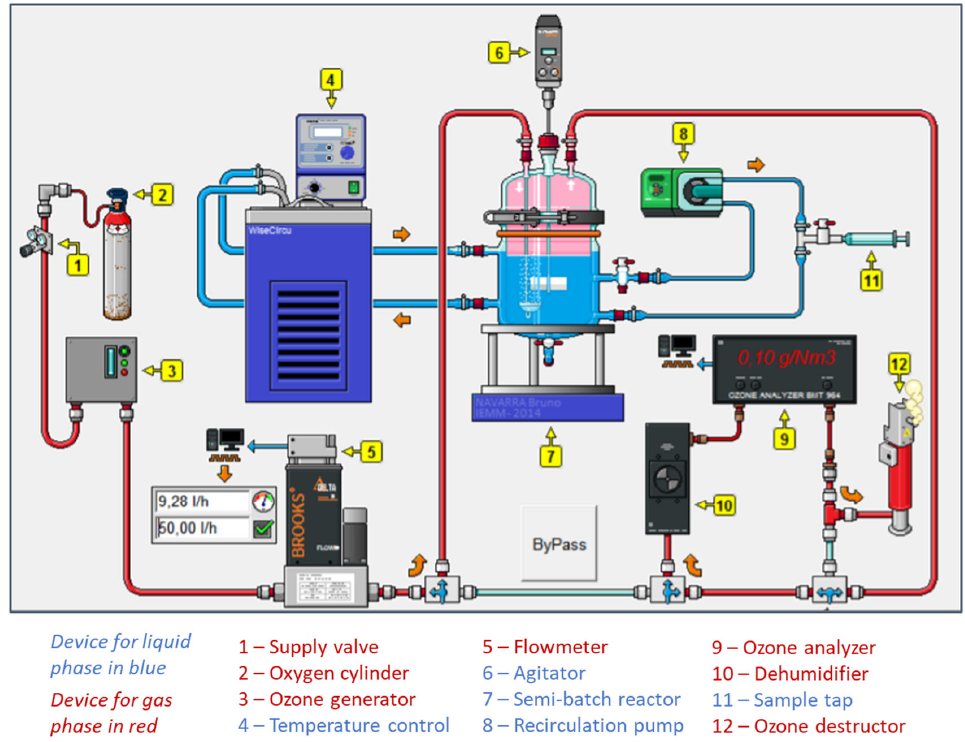
Figure 3. Scheme of the pilot ozonation system with a bubble column.